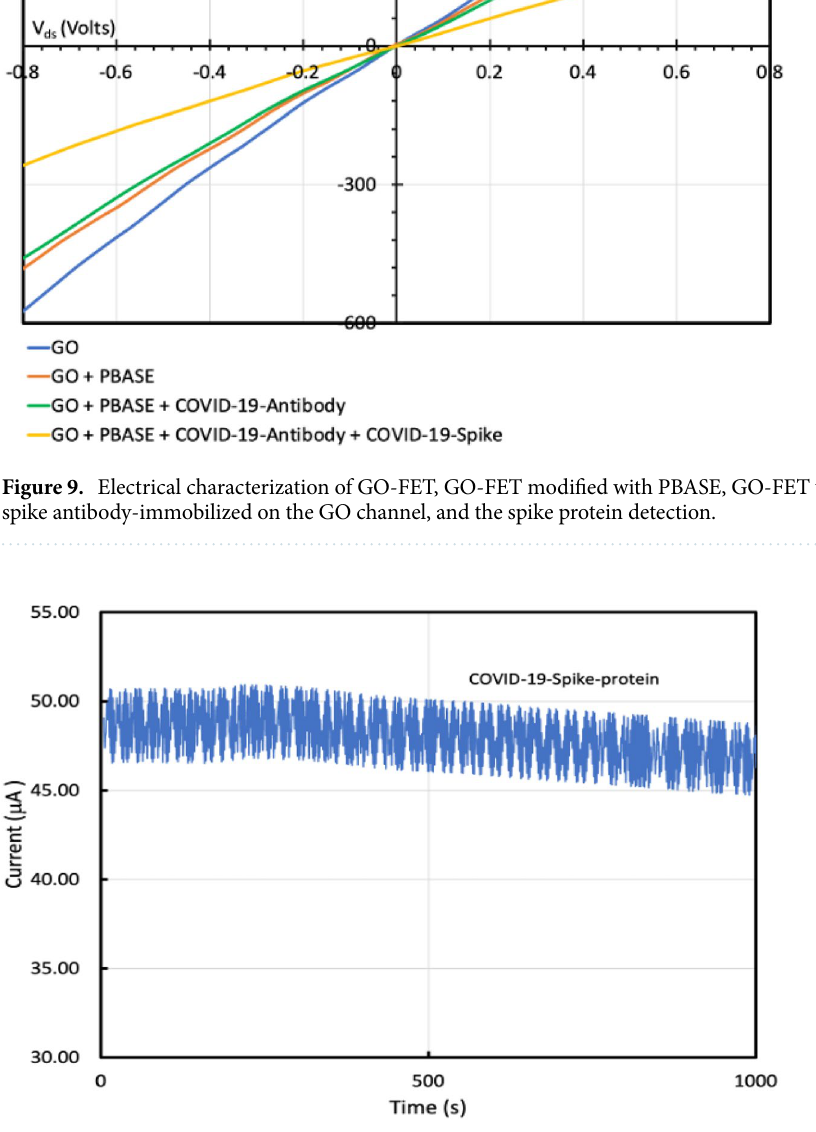
Figure 10. Variation in the drain current due to 0.4 μL drop of 1 pg/mL of COVID-19 spike antigen for GO-FET biosensor functionalized with Middle East Respiratory Syndrome (MERS)